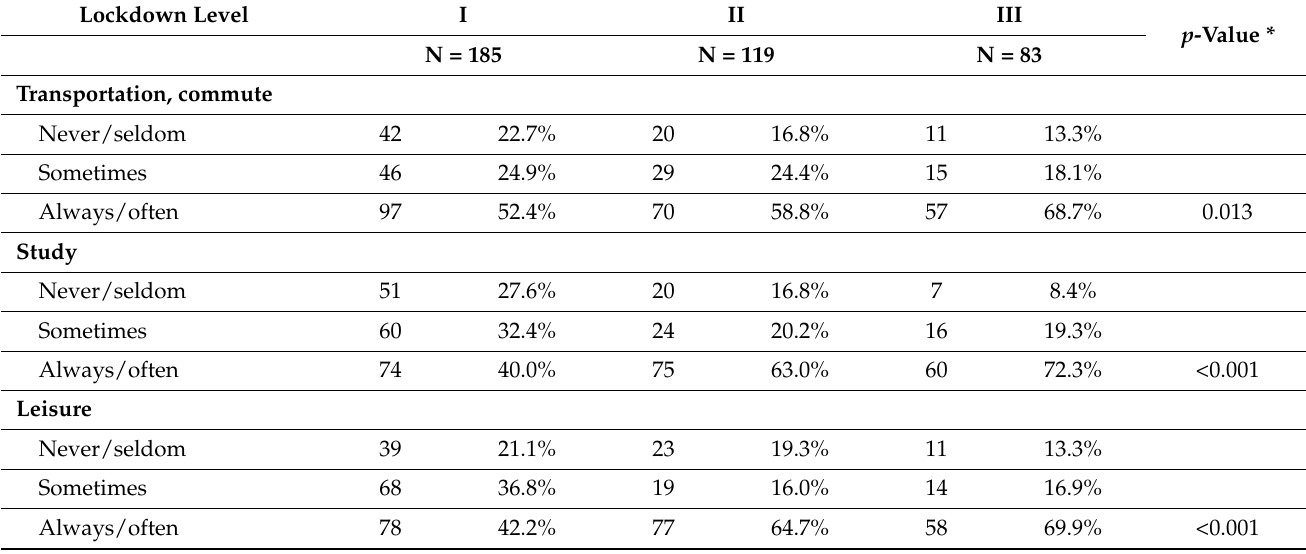
Table 3. Impacts of lockdown policy on the daily lives of international